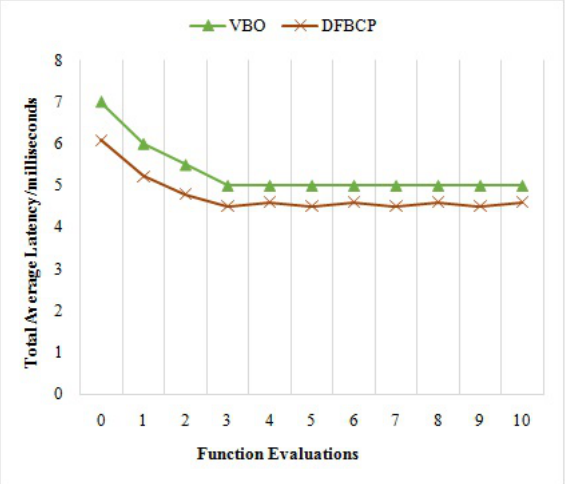
Figure 9. Convergence plots for capacitated controller placement problem for Internet2 OS3E